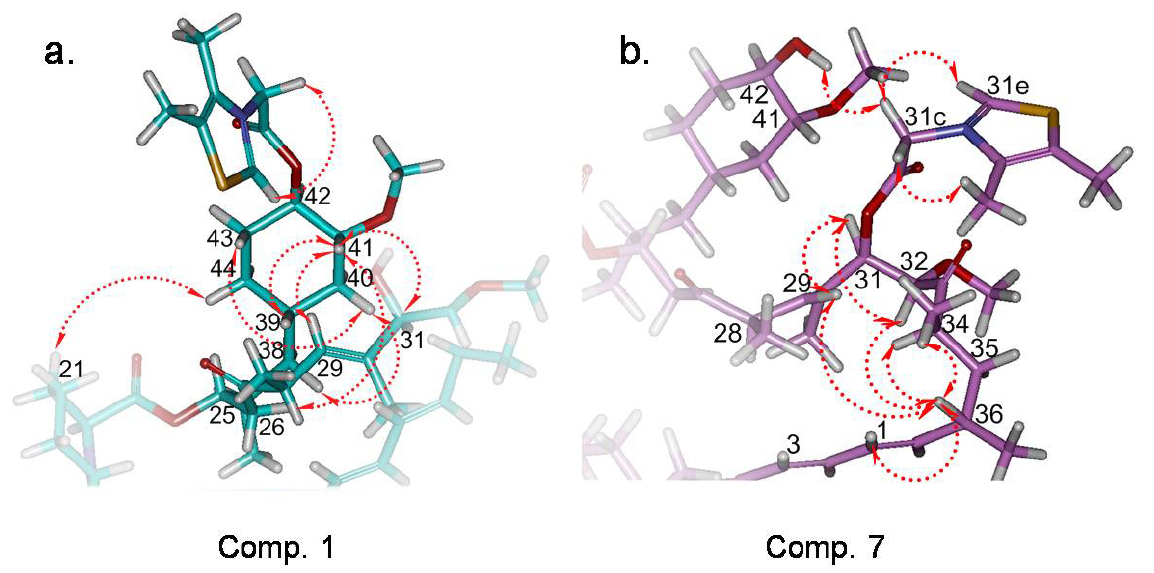
Figure 7. ( a ) Key partial simulated 3D structure of compound 1 (region A) and key ROESY correlations (red arrows); ( b ) Key partial simulated 3D structure of compound 7 (region B) and key ROESY correlations (red